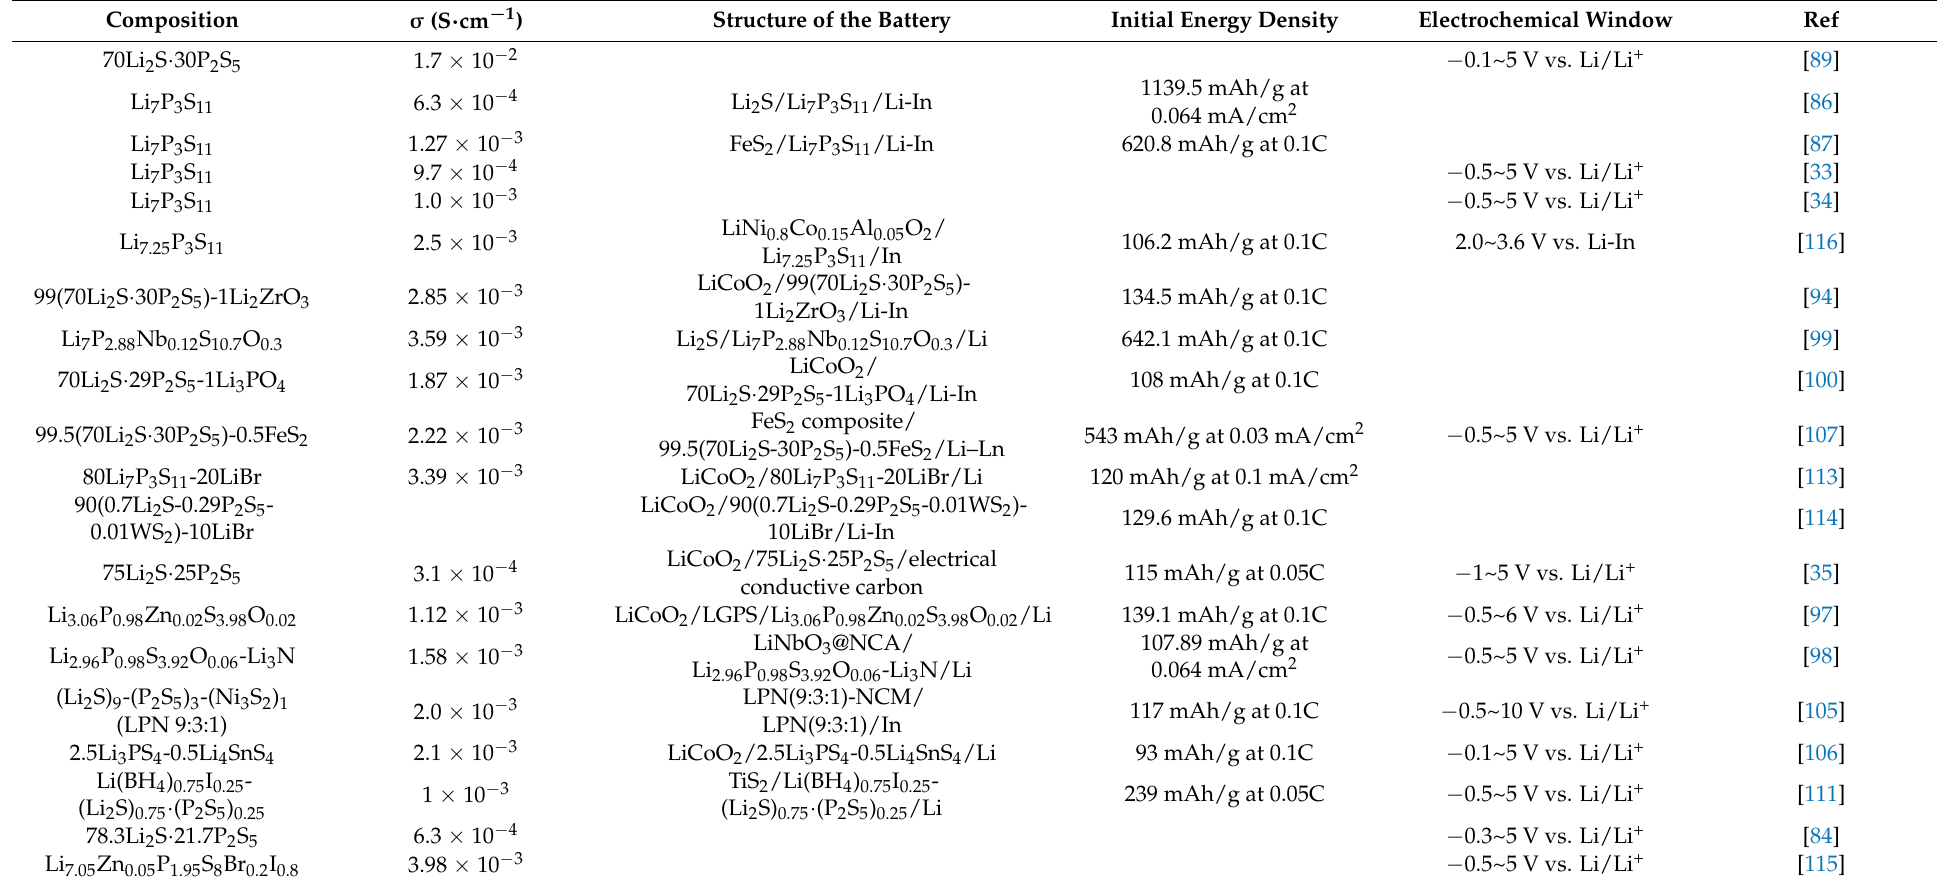
Table 2. Review of the various properties of LPS glass-ceramic SSE in recent